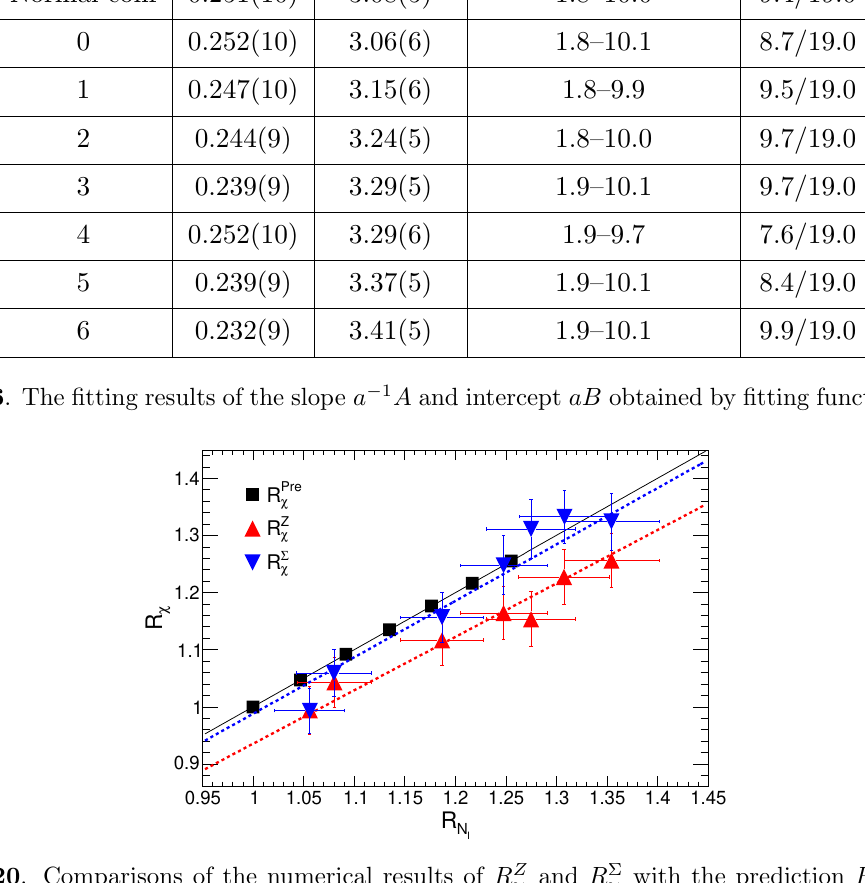
Figure 20 . Comparisons of the numerical results of R Z black, red, and blue lines indicate the (cid:12)tting results of R Pre , R Z